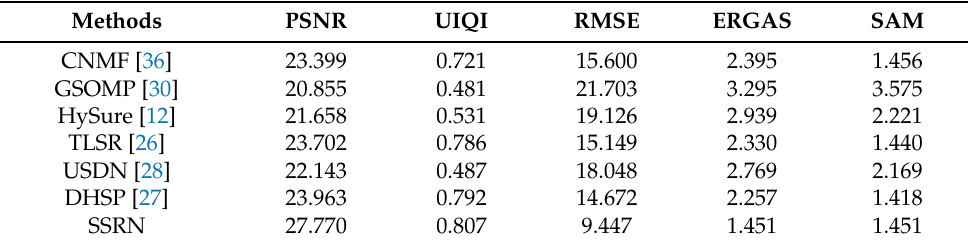
Table 8. Quantitative experimental results on the Ivanpah Playa database.